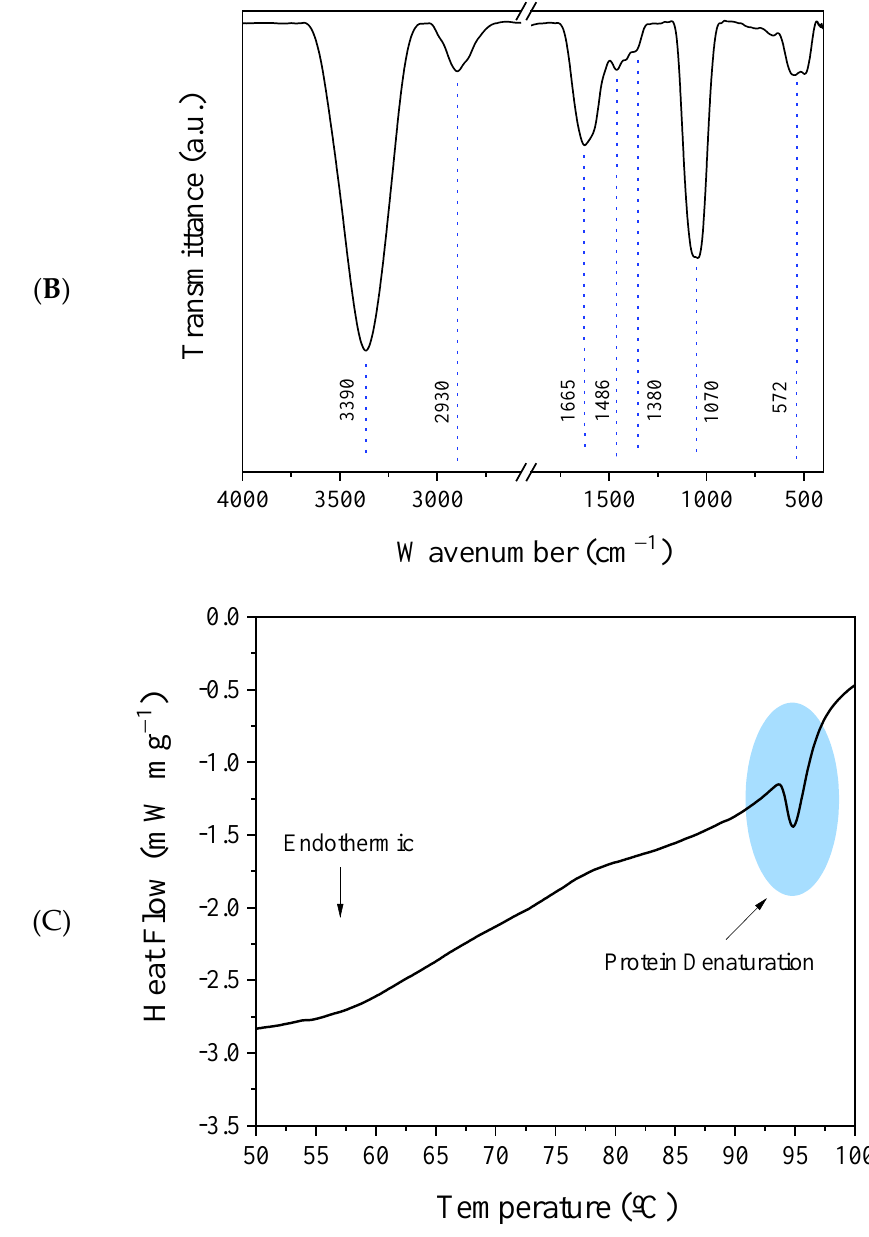
Figure 2. ( A ) Scanning electron micrographs of Agaricus bisporus biomass and isolated lectin micro- crystals (inset) recorded at 500- and 3000-times magnification, respectively. ( B ) FTIR spectrum and ( C ) differential scanning calorimetry data obtained for the lectin.